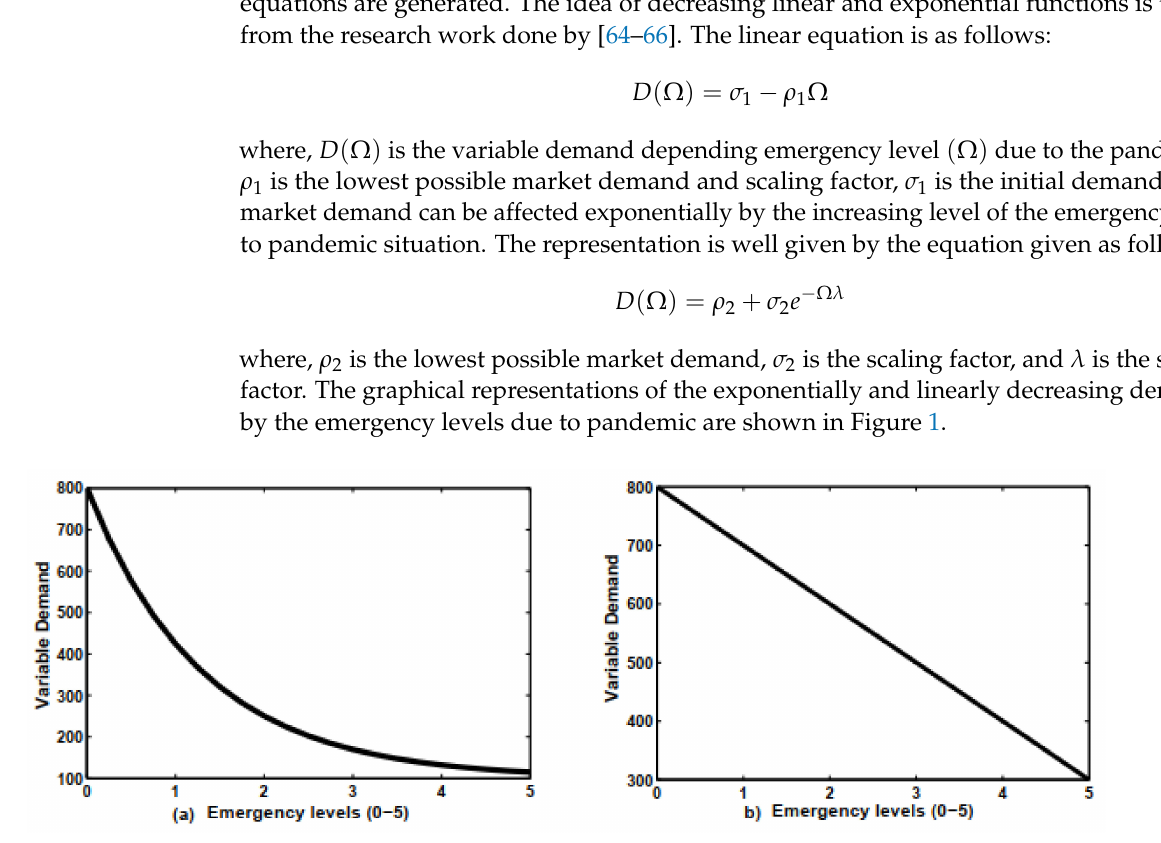
Figure 1. The effect of emergency levels on the market demand: ( a ) is showing an exponentially decreasing demand and ( b ) is representing the linear relationship between emergency levels and market